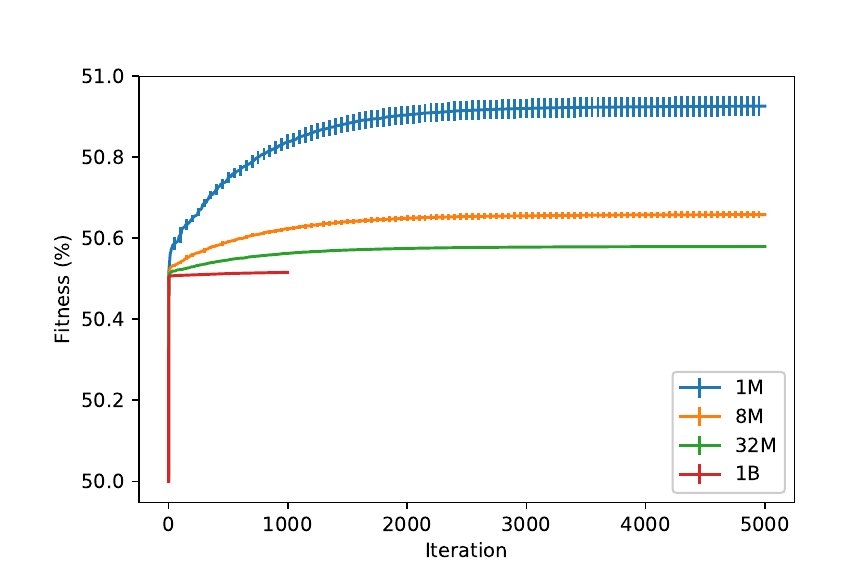
Figure A1. Best fitness value per iteration (mean ± std. dev. across 10 runs per algorithm) for the cGA on the discrete OneMax problem in four different dimensionalities.